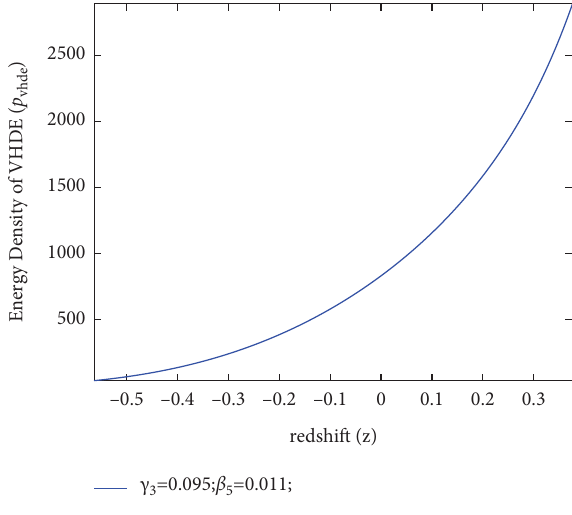
Figure 6: Te energy density of VHDE ( ρ for BT-IX.